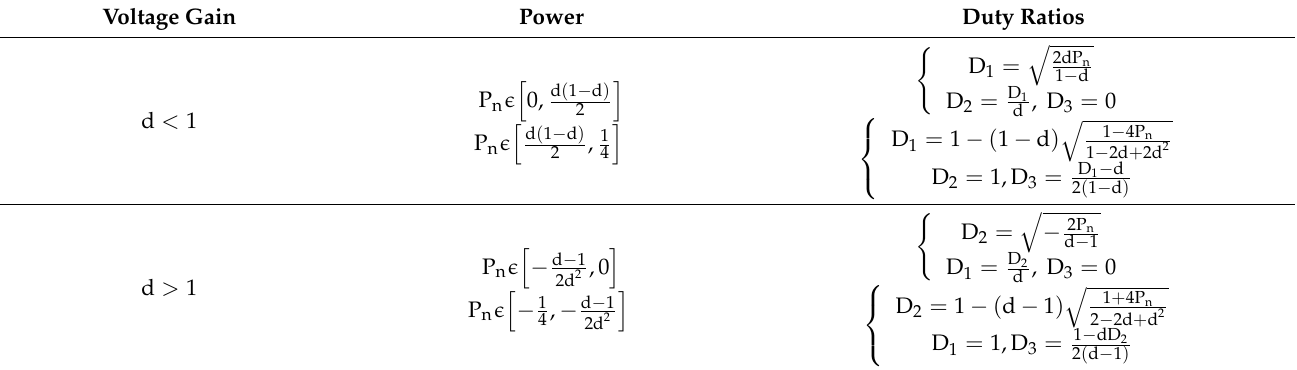
Table 1. Optimal duty ratios for the DAB converter in both forward/buck and backward/boost scenarios